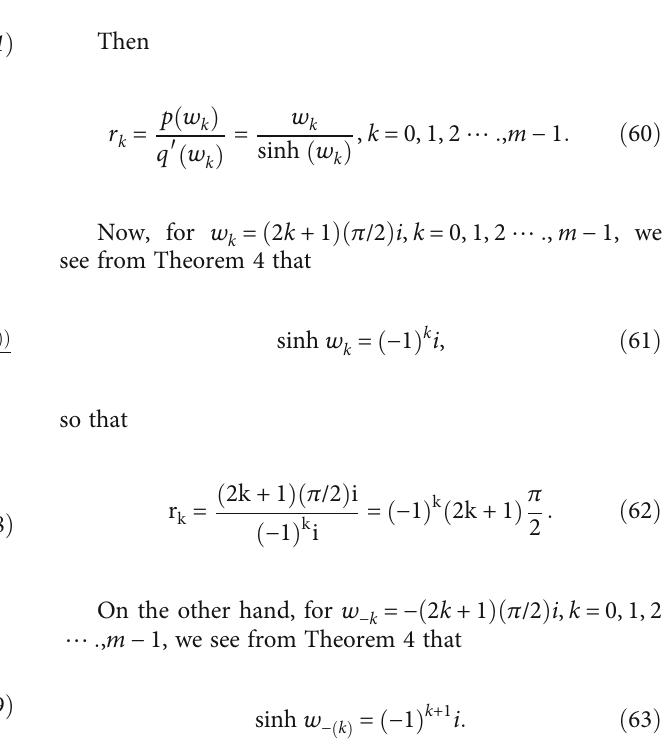
Figure 5: Solid lines represent ð TB Þ both normalized by the factor ð 1 + j x / α j n Þ